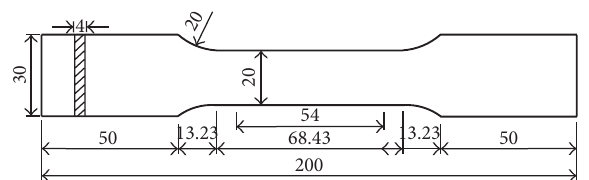
Figure 1: Diagram of specimen size (unit: mm).